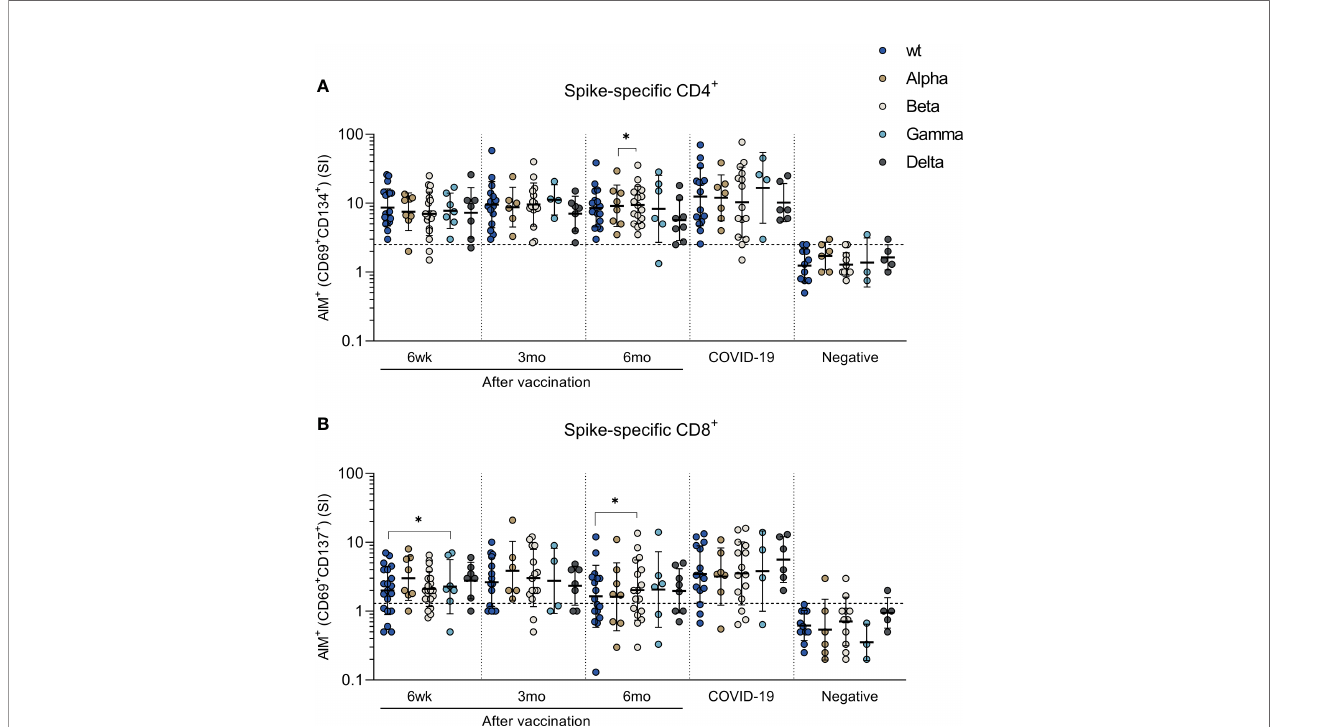
FIGURE 3 | T cell responses against SARS-CoV-2 variants of concern Alpha, Beta, Gamma and Delta. PBMCs collected from HCWs after BNT162b2 vaccination, COVID-19 patients, and negative controls were treated with DMSO or stimulated with peptide pools spanning the spike protein from SARS-CoV-2 wild type (S_wt) and four variants of concern Alpha, Beta, Gamma, and Delta. Stimulation indices (SI) were calculated by dividing the percentage of AIM + cells after spike peptide pool stimulation with the percentage of AIM + cells after DMSO stimulation. (A) CD4+ and (B) CD8+ T cell response was analyzed with the AIM assay and antigen speci fi c CD4 + responses were de fi ned with the expression of CD69 + and CD134 + , and CD8 + responses with the expression of CD69 + and CD137 + . Paired samples were analyzed with the Wilcoxon signed rank test and samples with no data on both data points were excluded from analysis. *p <